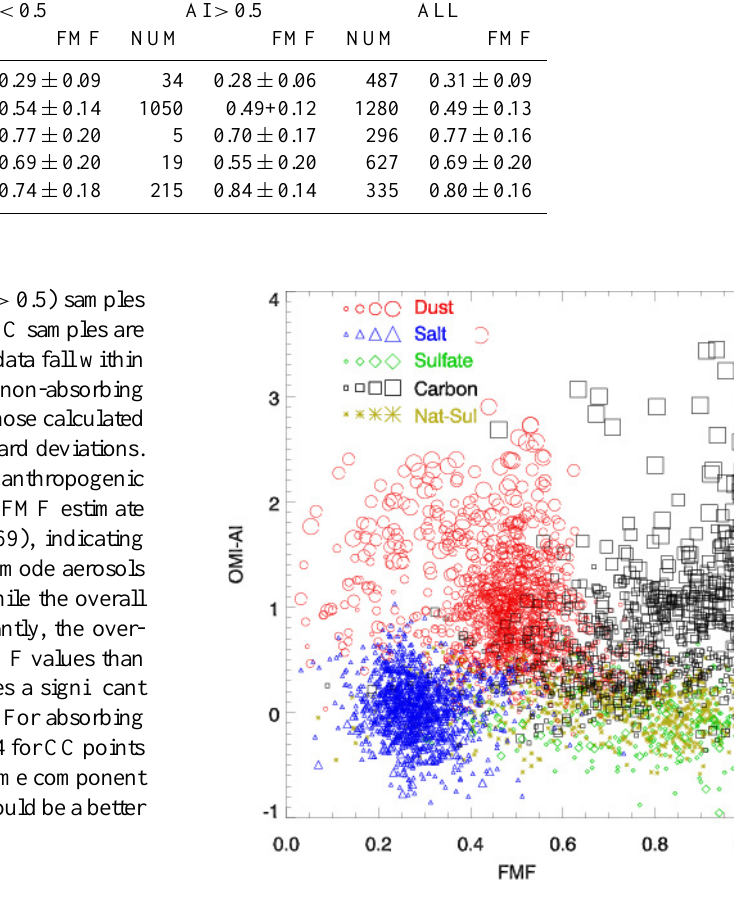
Table 4. Aqua CERES-SSF sample size (NUM) and mean FMF values for OMI-AI < 0.5 and OMI-AI > 0.5 samples showing the influence of UV-absorbing aerosols on the resultant statistics. Note that large differences appear when comparing SU and CC samples where the FMF for absorbing CC is much greater than the non-absorbing samples and the non-absorbing FMF for SU is greater than the absorbing sample. AI < 0.5